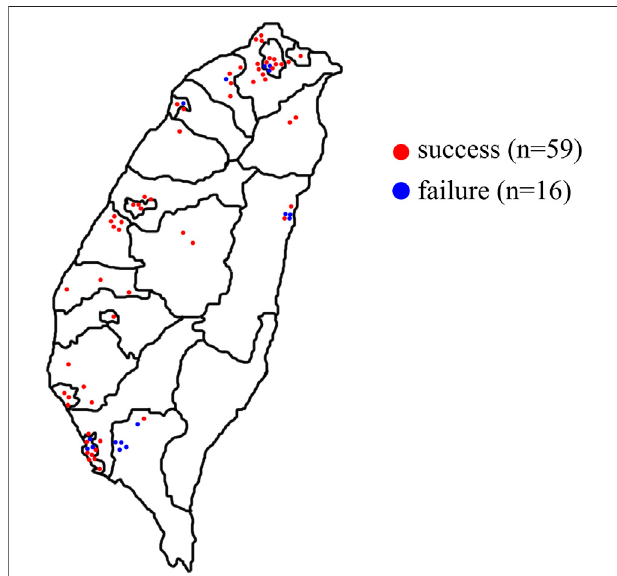
FIGURE 2 | Geographical distribution of pharmacies visited for skin whitening prescriptions in Taiwan. All dots were based on latitude and longitude coordinates. Red dots indicated successful pharmacies; blue dots indicated failed pharmacies.